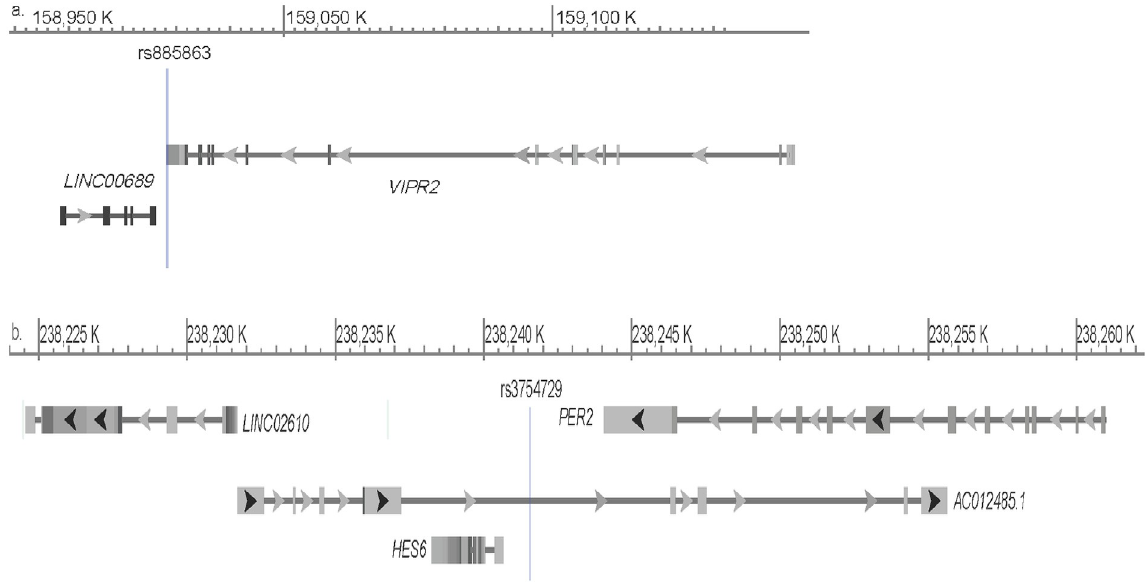
Fig 1. Schematic representation of SNP positions and their eQTL genes. a. VIPR2 rs885863, b. PER2 - HES6 rs3754729.